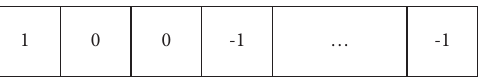
Figure 3: A chromosome composed of K